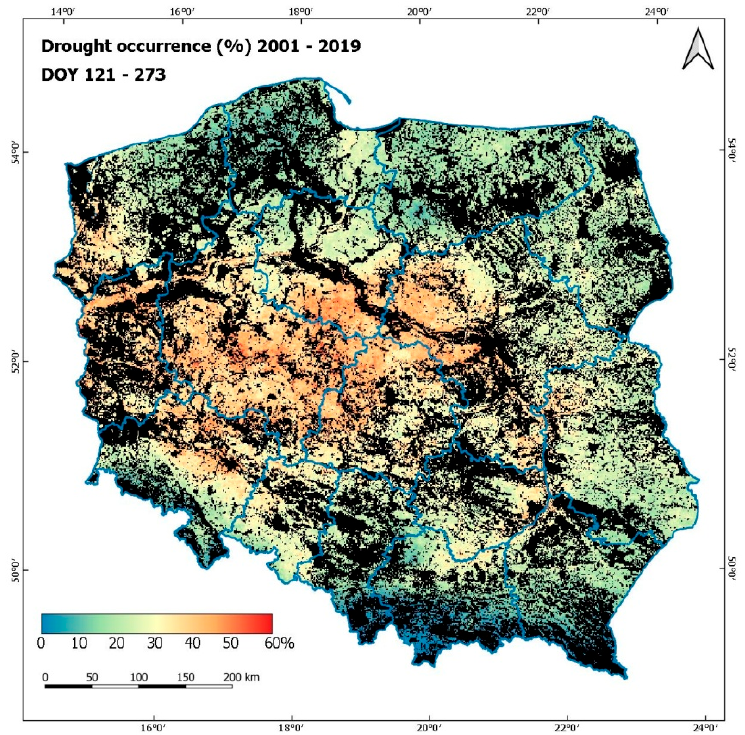
Figure 24. Percentage of drought occurrence in the 2001–2019 period (May 01–September 29).